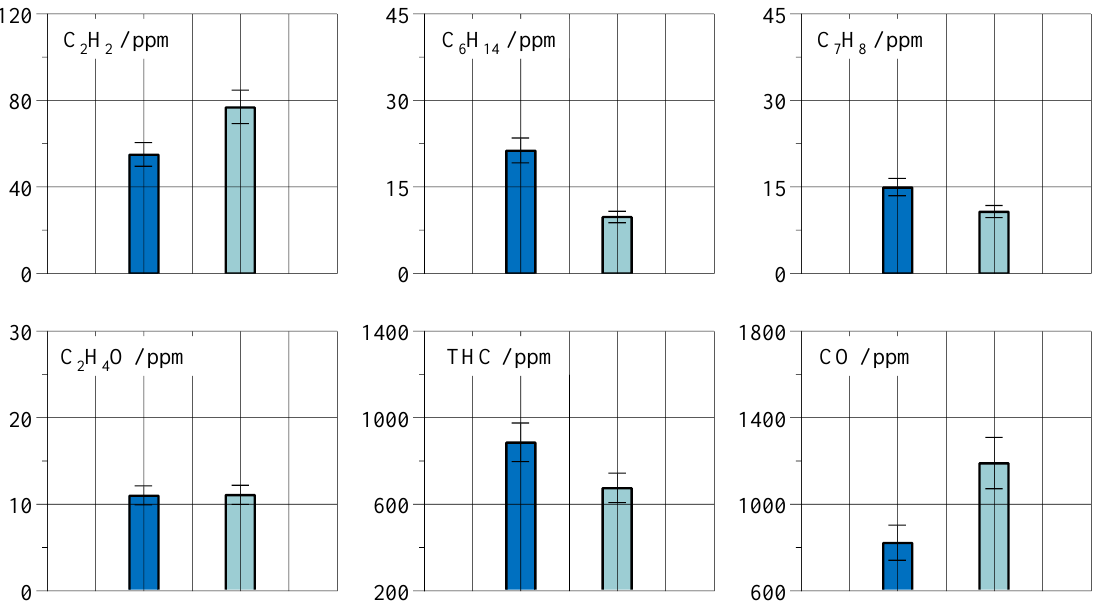
Figure 8. Measured species of near-wall gas sample of the GSV at n = 2000 1/min and IMEP = 3 bar.